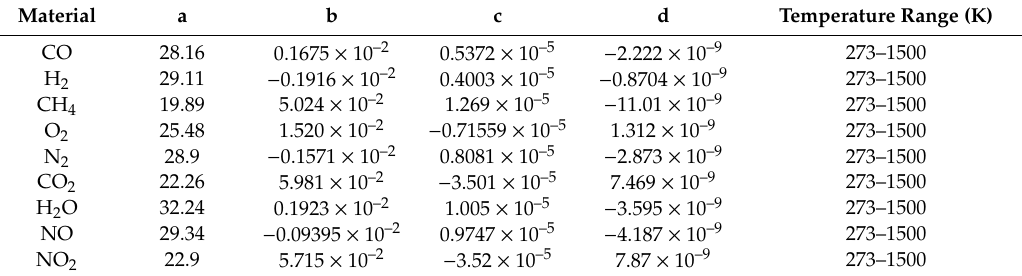
Table 6. The coe ffi cients of specific heat